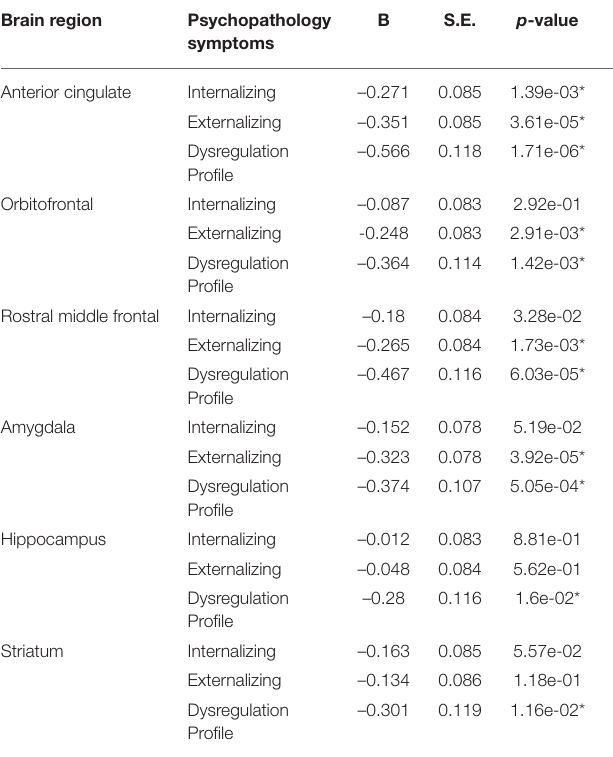
TABLE 2 | Hypothesis driven (sub-)cortical volume model